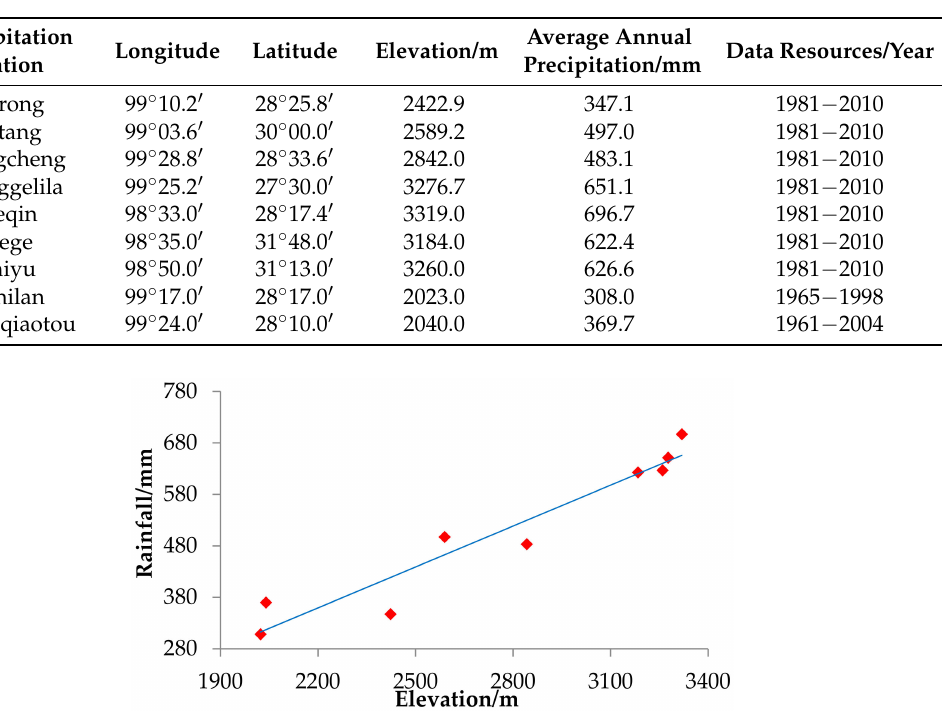
Table 1. Annual precipitation measured by precipitation station at different elevation.